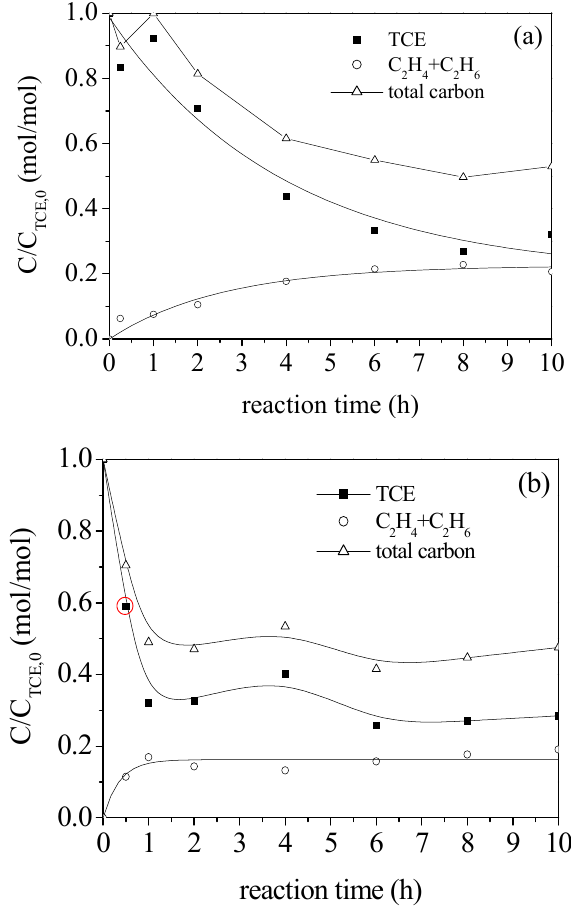
Figure 5. Degradation of trichloroethylene, and production of ethylene plus ethane on bare Pd/Fe nanoparticles ( a ) and Pd/Fe nanoparticles supported on mesoporous silica ( b ) with a same weight percentage of Pd to Fe at 0.10%. For the bare Pd/Fe nanoparticles, C TCE,0 = 23.7 mg/L (0.181 mmol/L), iron loading = 1.91 × 10 3 mg/L (34.2 mmol/L). For the supported Pd/Fe nanoparticles, C TCE,0 = 23.7 mg/L (0.181 mmol/L), iron loading = 203 mg/L (3.63 mmol/L), mesoporous silica loading = 8.10 g/L.